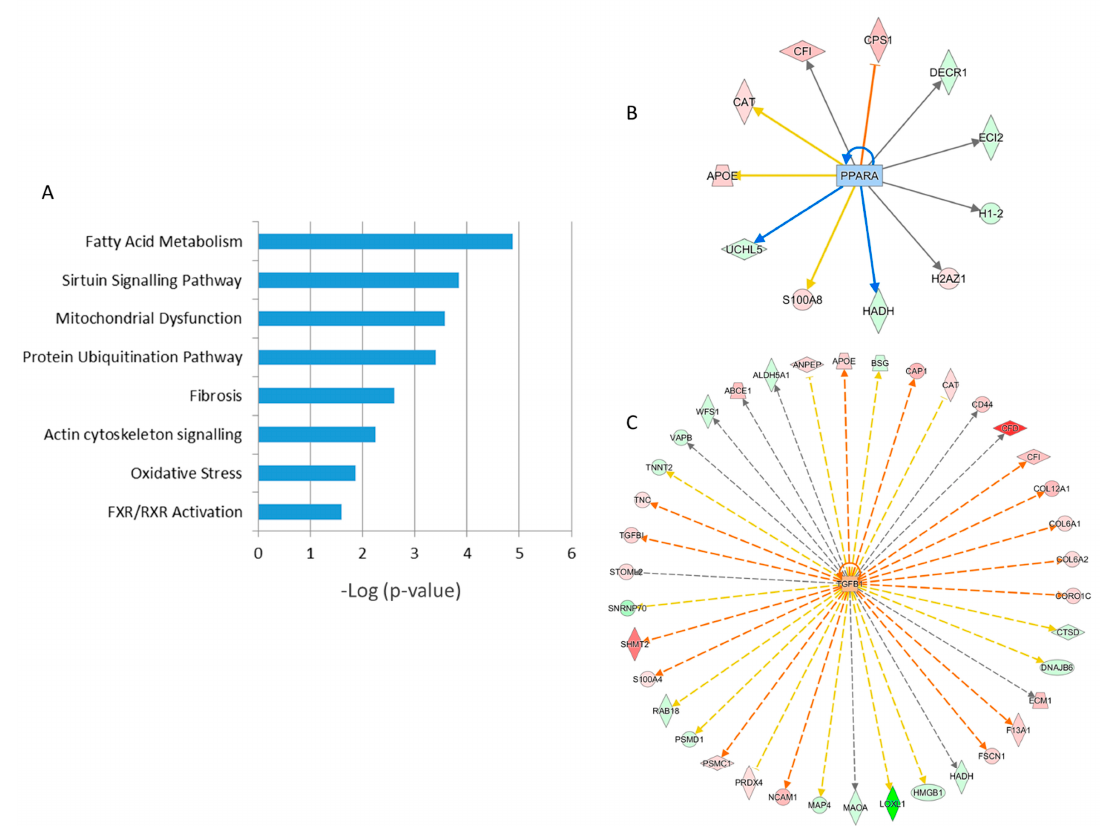
Figure 5. Pathway analysis of differentially regulated proteins from human FFPE heart tissues. The most significant canonical pathways altered by irradiation are shown. The analyses were generated using Ingenuity Pathway Analysis (IPA) (QIAGEN Inc., Hilden, Germany, https://www.qiagenbio- informatics.com/products/ingenuity-pathway-analysis) (Table S5). The bars indicate canonical pathways and the y-axis displays the − (log p ) enrichment significance. The tall bars are more significant than the short ones ( A ). Graphical representation of the deregulated protein networks with their upstream transcriptional regulators peroxisome proliferator-activated receptor (PPAR) alpha ( B ) and transforming growth factor beta (TGFB) ( C ) are shown. The upregulated proteins are marked in red and the downregulated in green. The nodes in blue (inhibition) and orange (activation) represent transcription factors. The full protein names are given in Table 1.